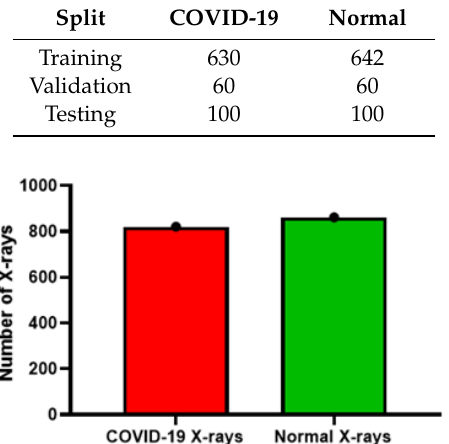
Table 1. Number of images per category used in training, validation, and testing phases without data augmentation.